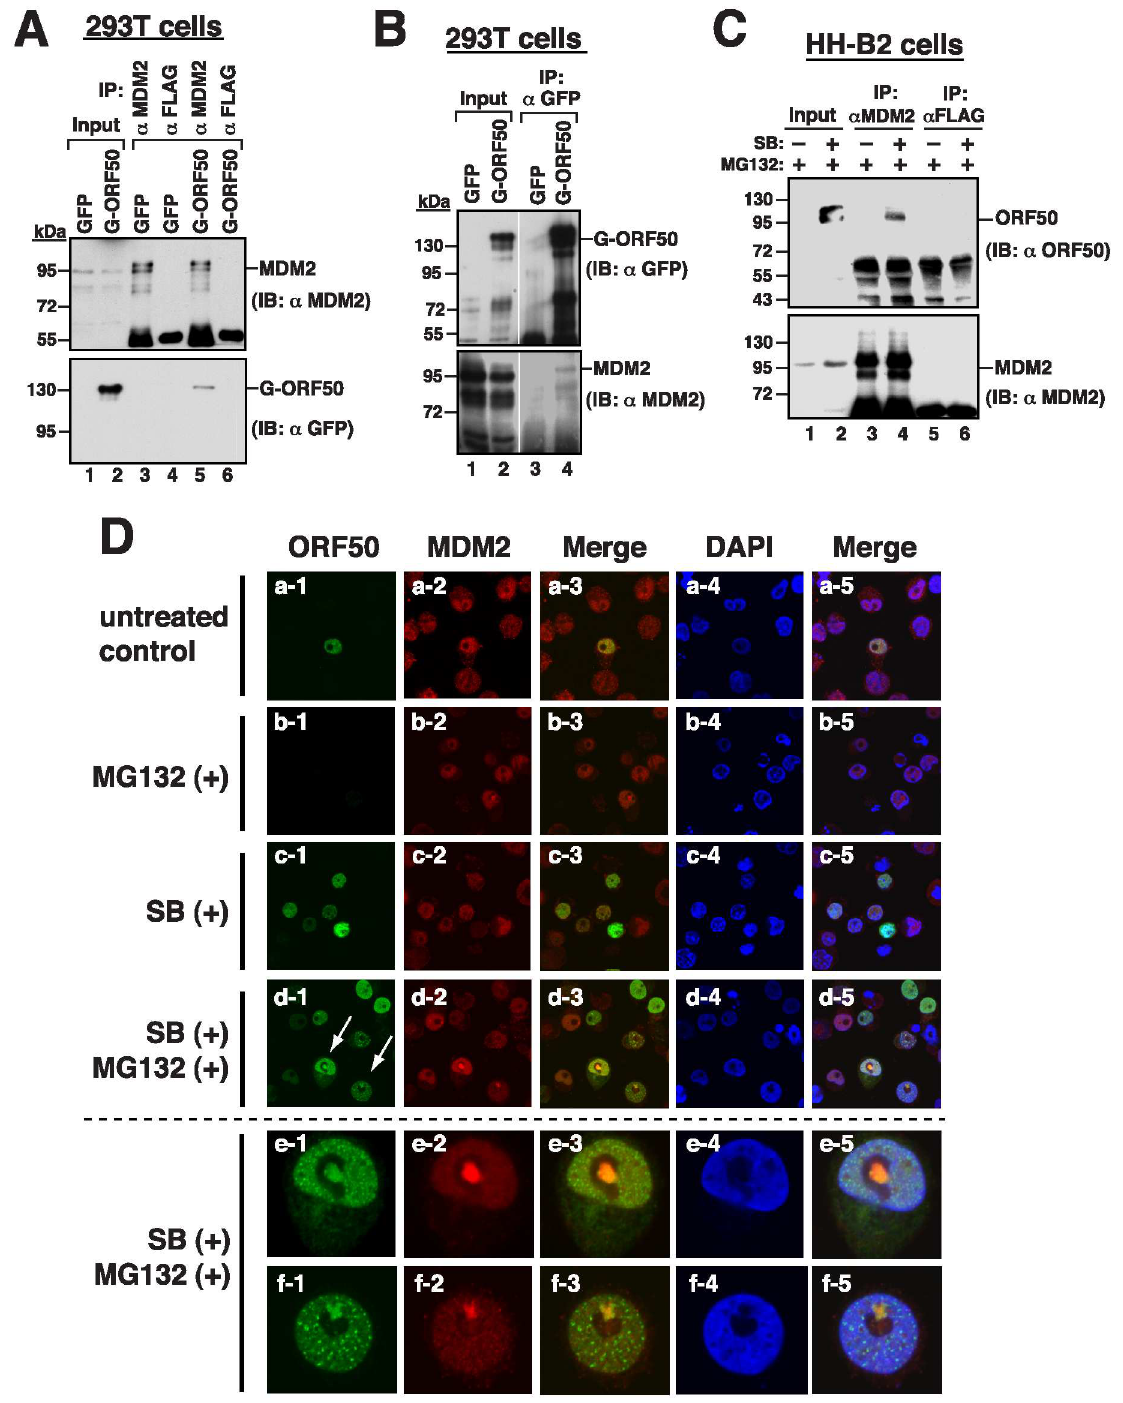
Fig 9. MDM2 interacts with ORF50 in cells. (A) 293T cells were transfected with the expression plasmid for GFP or GFP-ORF50. Cell lysates were harvested and immunoprecipitated with anti-MDM2 or anti-FLAG antibody. Cell lysates (input) and the resulting immunoprecipitates were probed with anti-MDM2 or anti-GFP antibody. (B) Same as in (A), except that the immunoprecipitationwas carried out using anti-GFP antibody. (C) Coimmunoprecipitation of MDM2 and endogenous ORF50 in HH-B2 cells. HH-B2 cells were untreated or treated with 3 mM sodium butyrate (SB). At 6 hr after SB treatment, cells were then treated with MG132 (5 μ M) for 20 hr. After the cell lysates were immunoprecipitated with anti-MDM2 or anti-FLAG antibody, the immunoprecipitated proteins were analyzedfor the existence of MDM2 and ORF50 by immunoblotting. (D) Colocalization